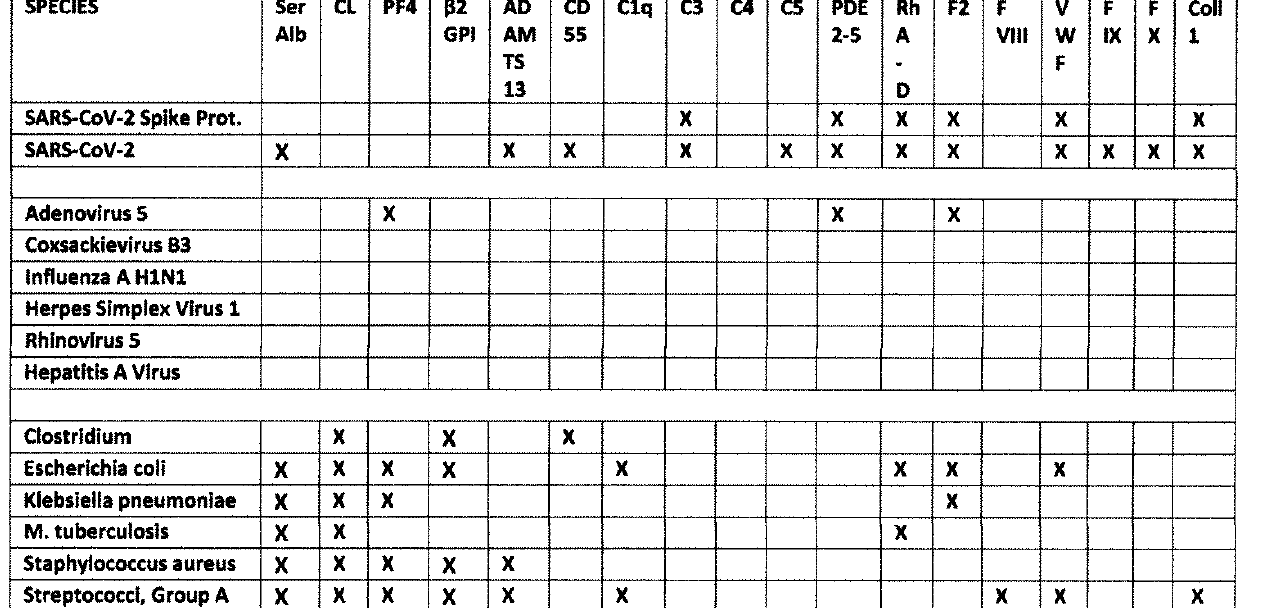
Figure 1. Predictions (indicated by X’s) of cross-reactivity based on significantly increased frequency of human blood protein mimics present in SARS-CoV-2, its spike protein, adenovirus 5, five other viruses (three newly added to this figure), and six bacteria associated with severe COVID-19 [39,40]. The X’s in the virus rows indicate that the number of similarities between a virus protein and a human blood protein was at least three times the average number found among the control viruses. The X’s in the bacteria rows indicate that at least one high-similarity, low-probability sequence was shared with the human blood protein [40] . CL = cardiolipin; Ser Alb = human serum albumin; β2GP = beta 2 glycoprotein; ADAMTS13 = von Willebrand factor-cleaving protease or VWFCP; CD55 = Complement decay-accelerating factor; C1q, C3, C4 and C5 are complement proteins 1q, 3, 4 and 5; PDE = phosphodiesterase; Rh = rhesus factor; F2, FVIII FIX and FX are blood coagulation factors; VWF is von Willebrand’s factor; Coll 1 is collagen typ e 1.